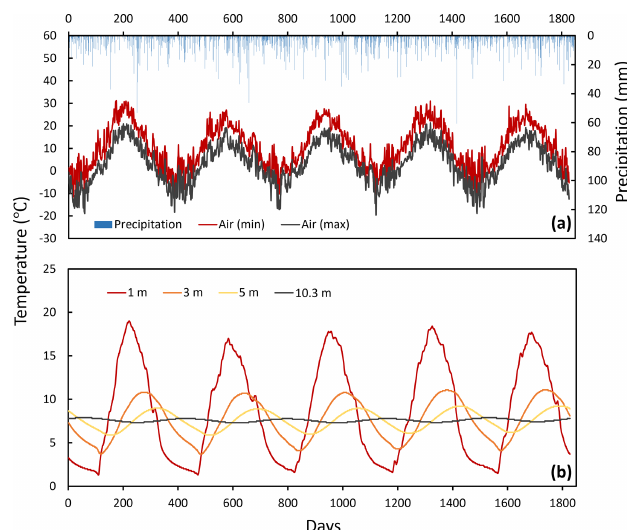
Figure 9. Historical simulation data for the years of 2016–2020 ex- tracted from SHAW. (a) Maximum and minimum daily air temper- ature and total rainfall input to the model. (b) Subsurface tempera- tures at various depths in response to surface forcing. The temper- ature data at depths of 1 and 3m were extracted from the surface domain, whereas the others are from the lower domain. Modelled amplitudes may be compared to measured spring signals to estimate their source